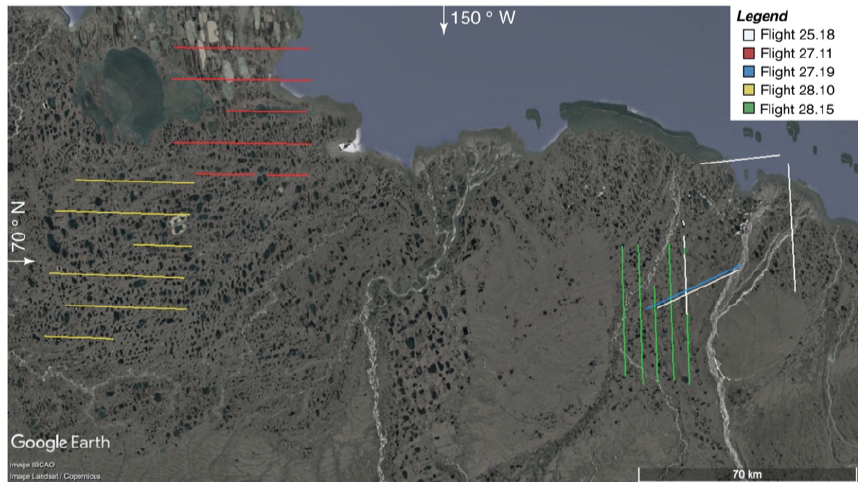
Figure 2. Flight tracks for the August 2013 campaign, where the paths represent sections of the flights that were suitable for flux calculations (aircraft flying on a straight, level path below 50m). (Map image credit: Google